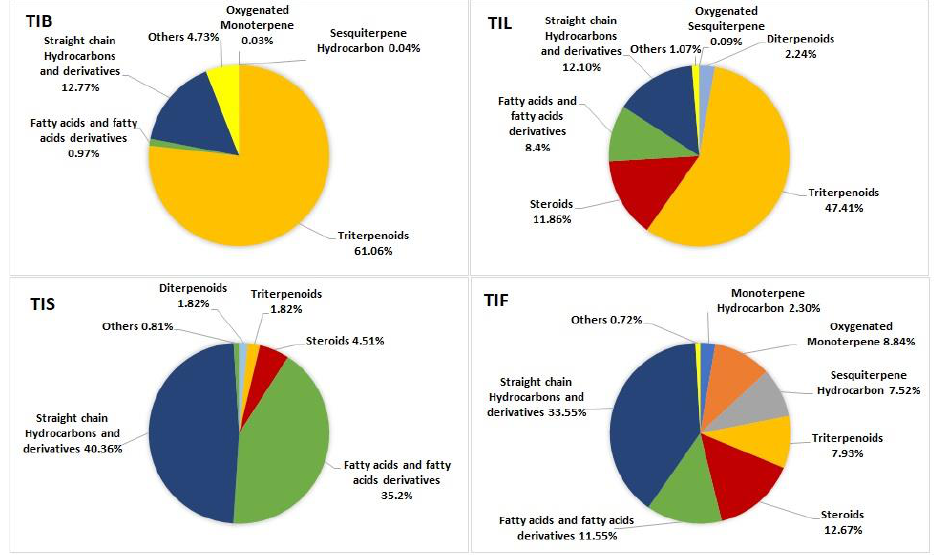
Figure 2. Pie charts demonstrate distribution of metabolite classes in percentages within various organs: TIB (bark), TIL (leaves), TIS (seeds), and TIF (fruits) of Tamarindus indica. The fatty acids previously identified in the seeds of Tamarind from Sudan by Table 1. Chemical profile of n -hexane extract from various organs of T. indica : TIB (bark), TIL Ibrahim et al. [40] were characterised as palmitic acid, oleic acid, and eicosanoic acid in (leaves), TIS (seeds), and TIF (fruits) using GC/MS analysis. addition to the identification of β -amyrin, β -sitosterol, and campesterol. Cis -vaccenic acid, 2-methyltetracosane, β -sitosterol, 9,12-octadecadienoic acid ( Z , Z )-, and n-hexadecanoic acid were reported as the major metabolites identified in the oil of T. indica seeds collected from Nigeria. Another study by Carasek and Pawliszyn [41] reported that the volatile compounds in the tamarind fruit collected from Brazil included phenylacetaldehyde and furfural. Aldehyde and ester compounds were mostly identified by using